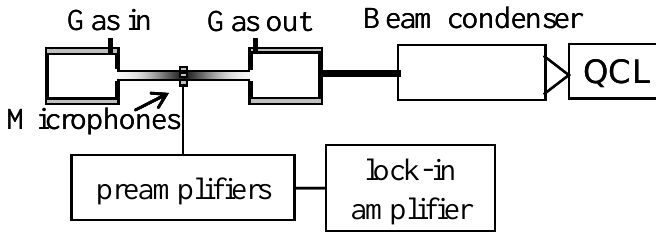
Figure 1. Block diagram of the PAS